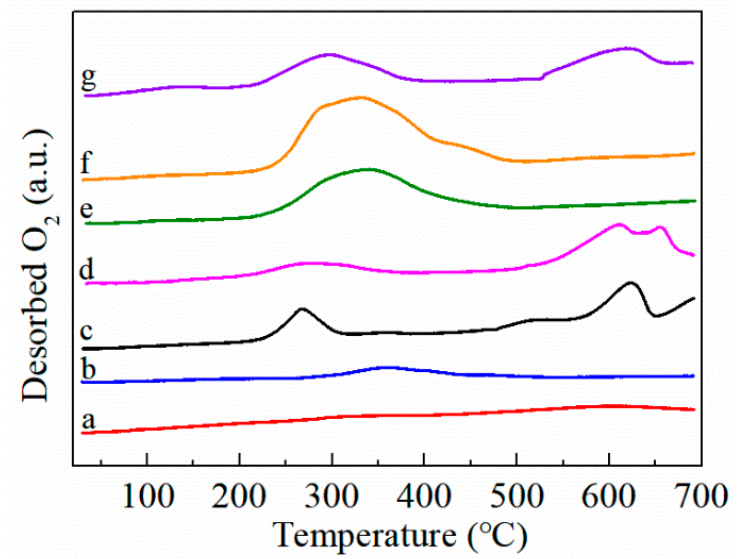
Figure 6. O 2 -TPD profiles of (a) CeO 2 , (b) Fe 3 O 4 , (c) MnO 2 , (d) MnO 2 -CeO 2 , (e) FMC-1:5:5, (f) FMC-